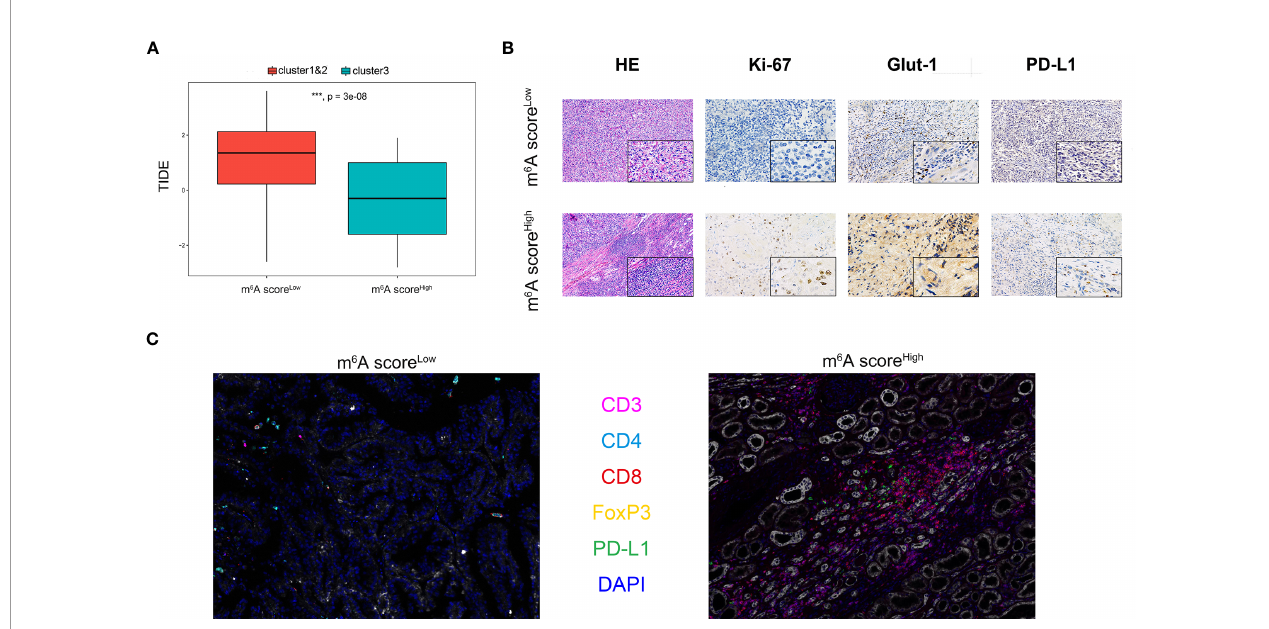
FIGURE 6 | Distinct immune microenvironment of ccRCC between m6A score Low and m6A score High groups in silico and in vitro . (A) TIDE algorithm was used to indicate association between m6A score and predictive bene fi ts for ccRCC patients receiving from ICTs. (B) H&E and immunohistochemistry staining were performed in different m 6 AMS clusters. (C) The in fi ltration of CD8 + , CD4 + , CD3 + and FOXP3 + immune cells and expression level of PD-L1 were evaluated using opal multispectral imaging (***p<